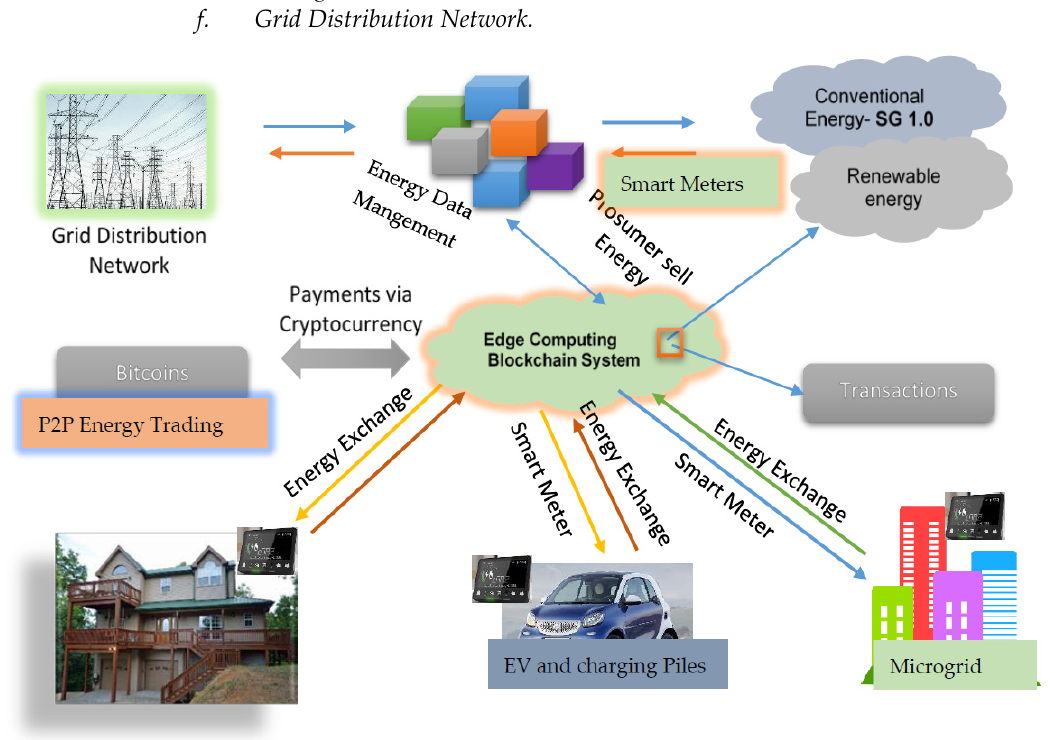
Figure 2. Overall structure of a Distribution Prosumer/SG 2.0 System.